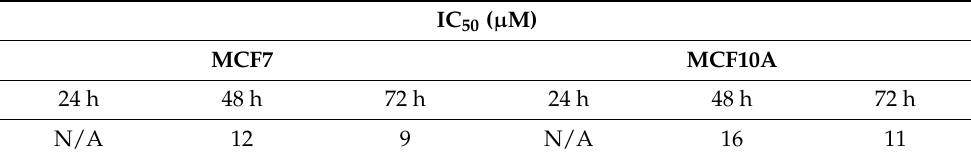
Table 1. IC 50 values were determined by testing increasing concentrations of c ex -NDI for different time intervals on MCF7 and MCF10A cells by MTT assays. N/A: not applicable.